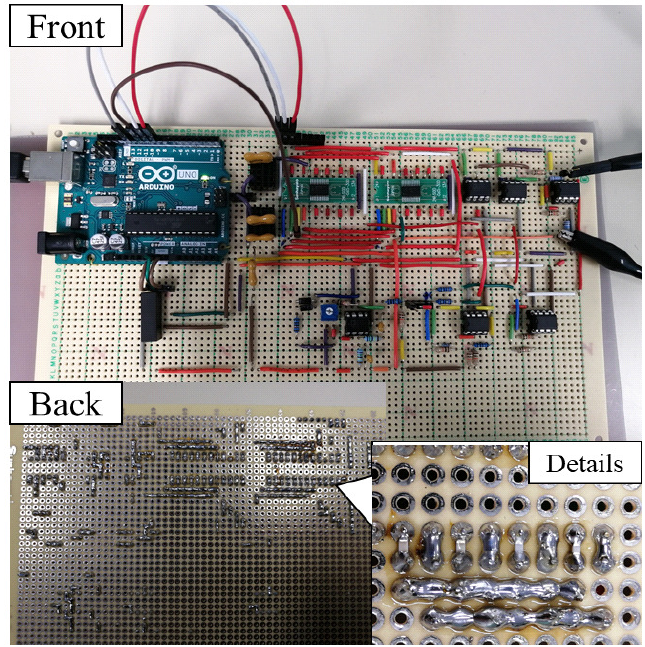
Figure 13. Evaluation circuit on a universal board. We use two sets of ceramic capacitors to simulate the EBI capacitance. The chip capacitors for constructing the DTC are soldered on the back side of the board.